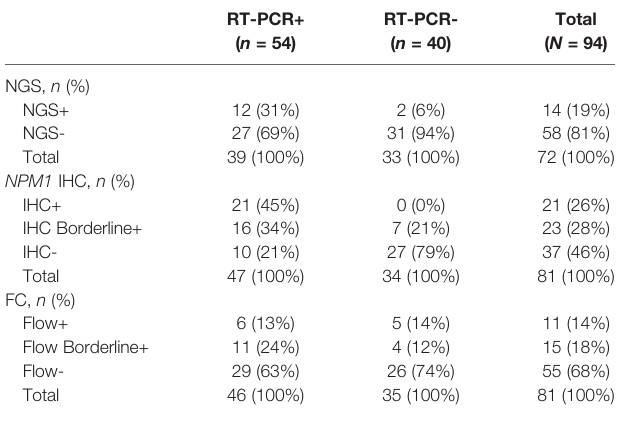
TABLE 1 | Summary of Results: NPM1 Type A Mutation